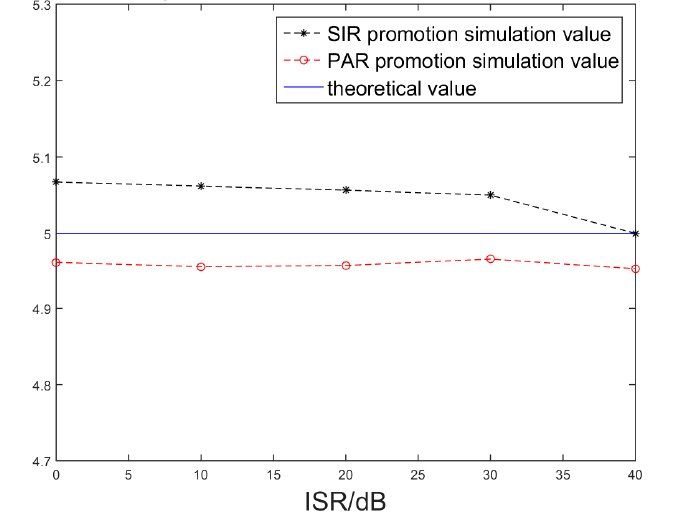
Figure 15. SIR and PAR promotion simulated and theoretical value.